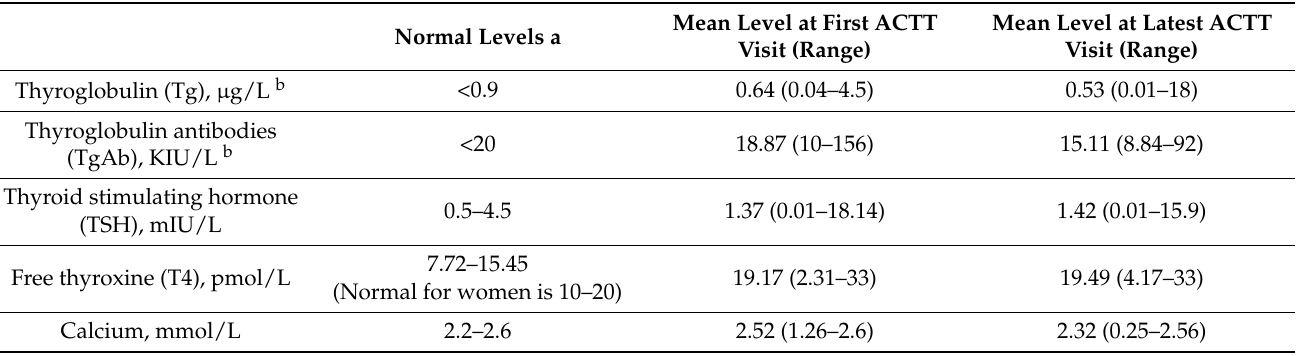
Table 3. Blood test levels for thyroid cancer patients in After Cancer Treatment Transition (ACTT) clinic. Normal Levels